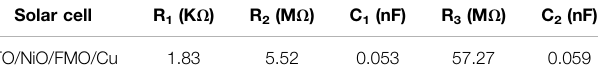
measurement we exact abuilt-in potentialof1.38 V (von Hauff, 2019).